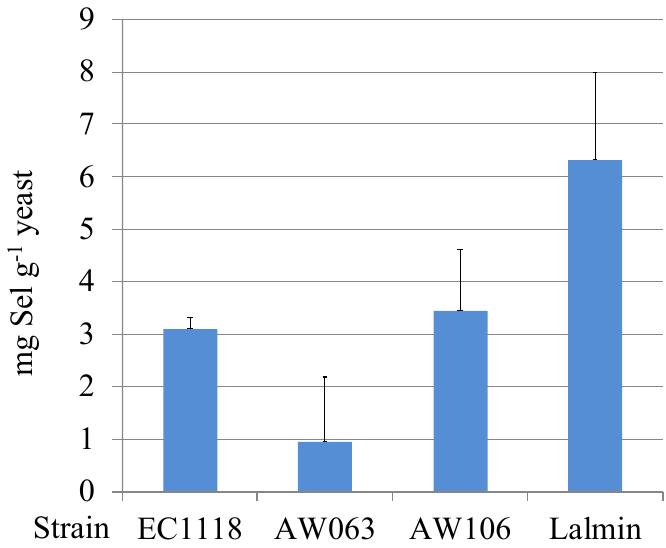
Figure 1. Selenium accumulation capability of selected strains. Yeast grown in optimized selenium accumulation medium (OSAM) were assayed for their selenium content per gram of yeast.